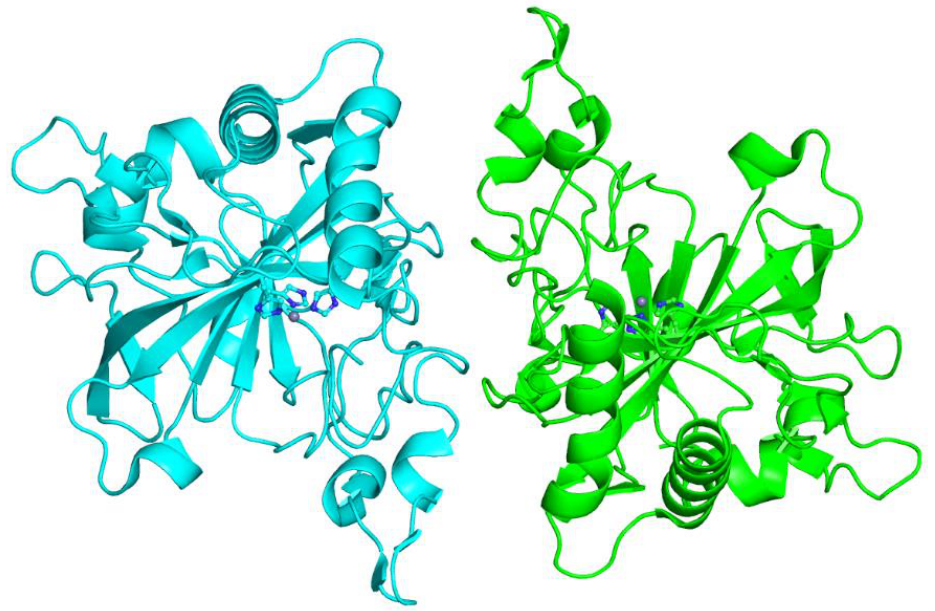
Figure 5. Cartoon representation of the algal dCAII dimer. One subunit is colored in cyan and the other one in green; the zinc ion and its coordinating histidines are also depicted.